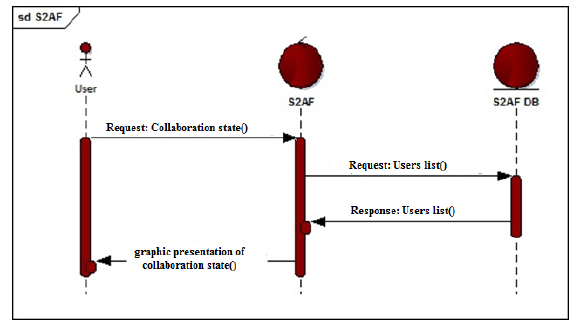
Figure. 10. Sequence Diagram providing the indicators of Feedback performance: the state of collaboration between users